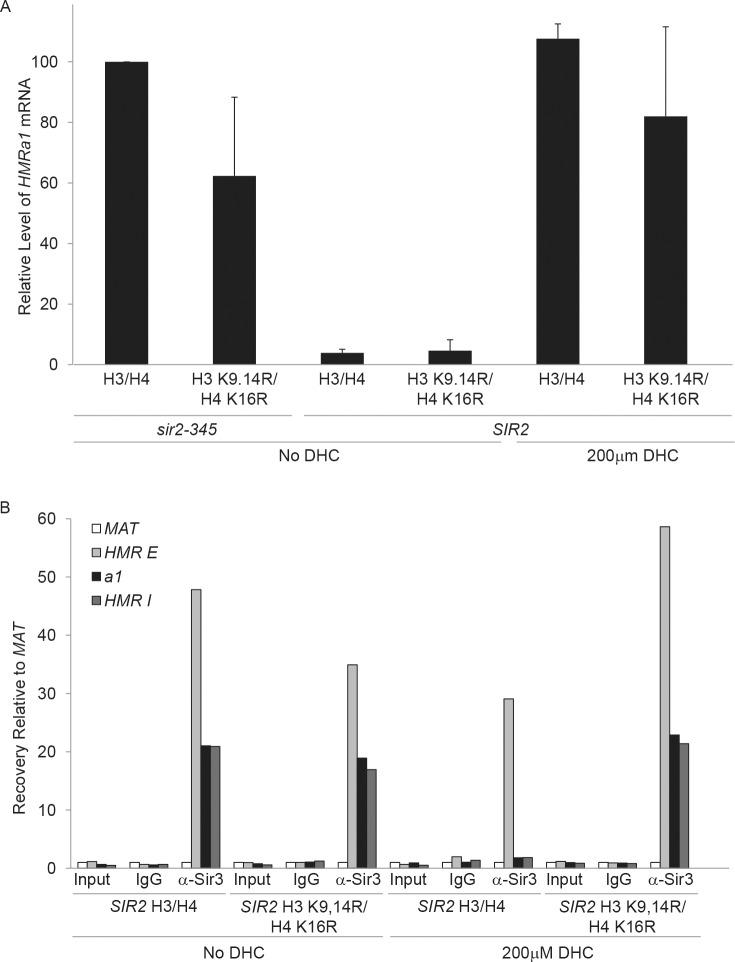
DHC prevents Sir spreading and mimics the catalytically inactive sir2-345 mutant.a Transcriptional analysis by qRT-PCR of a1 at HMR relative to an internal control (SCR1) was determined for strains with the indicated genotypes grown in rich (YPD) media in the absence or presence of 200 μM DHC, and compared to that observed in sir2-345 mutants expressing wild-type H3 and H4, which was set to 100% (AVG ± SD, n = 3). Data was calculated as: 2[(a1CT − SCR1CT)Indicated strain − (a1CT − SCR1CT)sir2-345 H3/H4]. b Sir3p binding at MAT, HMR E silencer, a1, and I silencer in the absence or presence of 200 μM DHC was monitored by ChIP using IgG or anti-Sir3p antibodies and qRT-PCR in SIR2 and sir2-345 strains expressing wild-type or hypoacetylated H3/H4. Efficiency of co-precipitation of each locus is expressed relative to MAT and was calculated as: Locus IP/MAT IP = 2[(MATCT − LocusCT); See also S2 Fig.